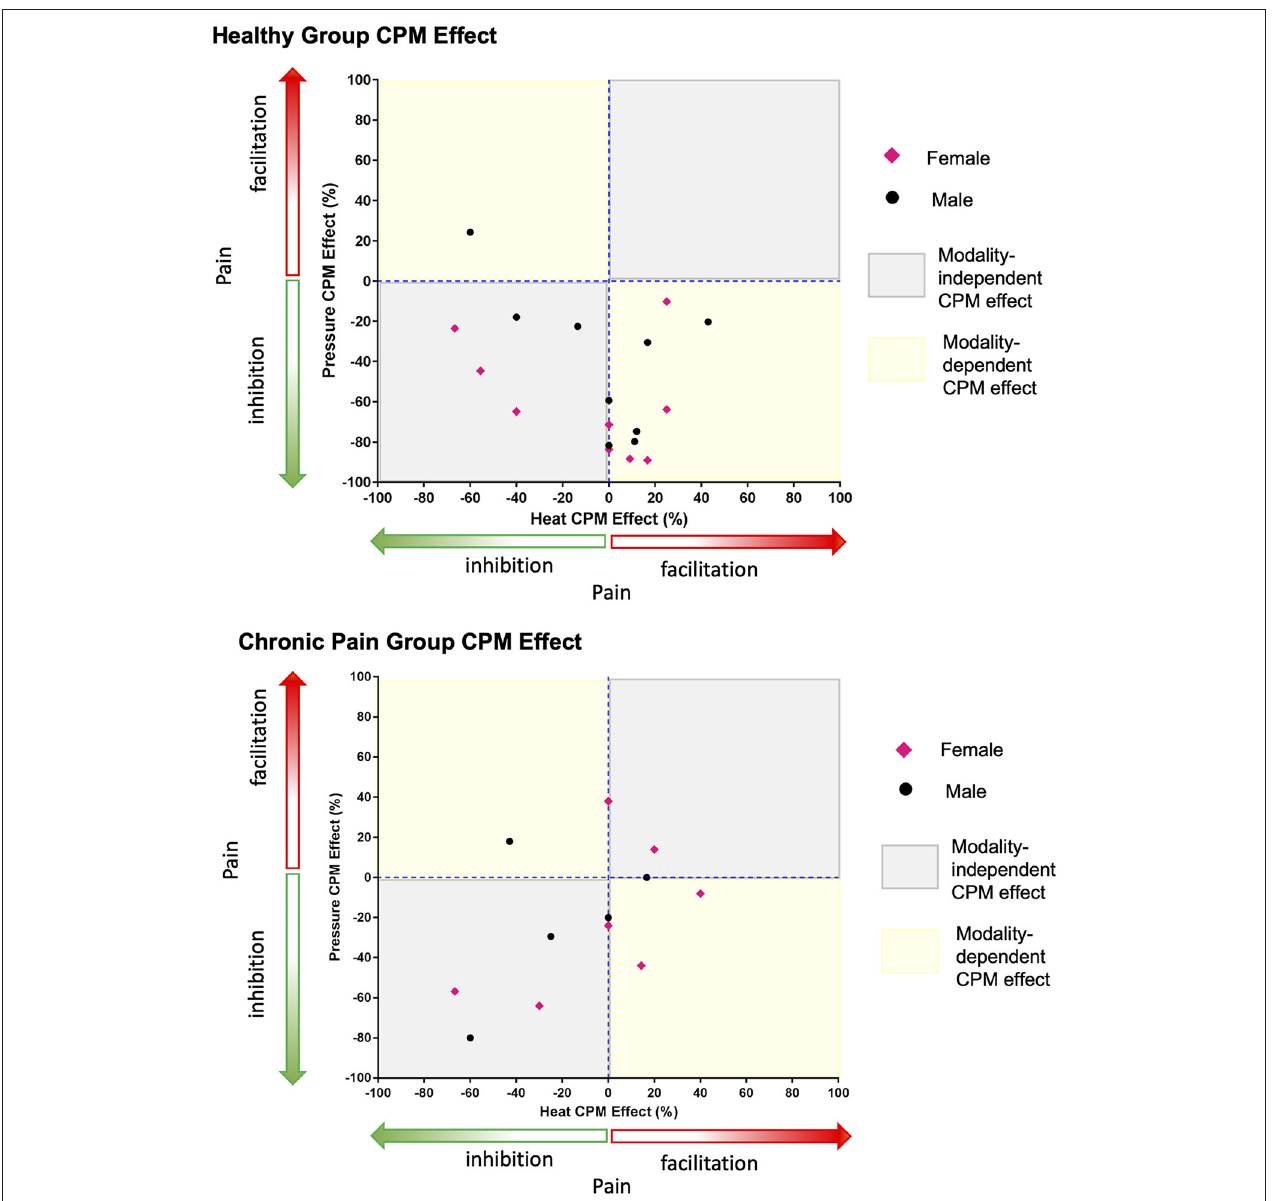
FIGURE 3 | Greater number of healthy individuals demonstrate a modality-dependent CPM effect compared to individuals with chronic pain. Points that fall in the modality-dependent yellow quadrants reflect individuals who could be classified on the opposite ends of the CPM effect spectrum (facilitatory vs. inhibitory) depending on whether the paradigm is heat or pressure based. Modality-independent gray quadrants reflect individuals who would have the same type of CPM effect regardless of the